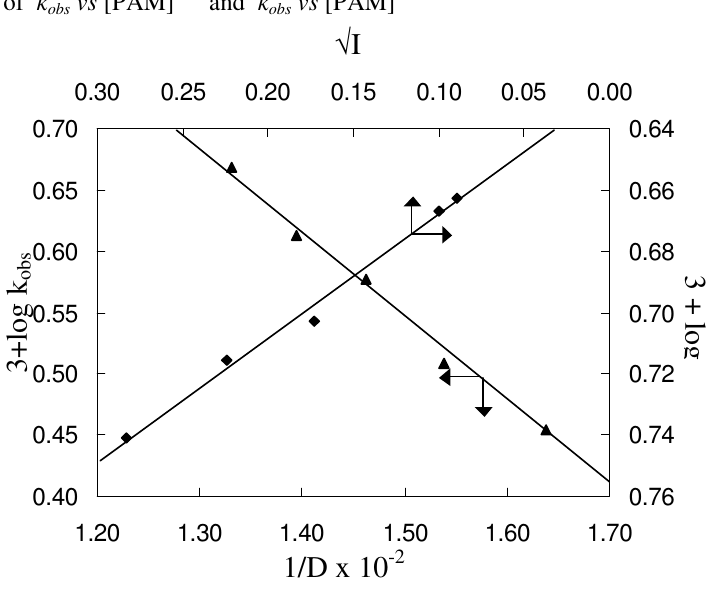
Figure 2. Plot of k